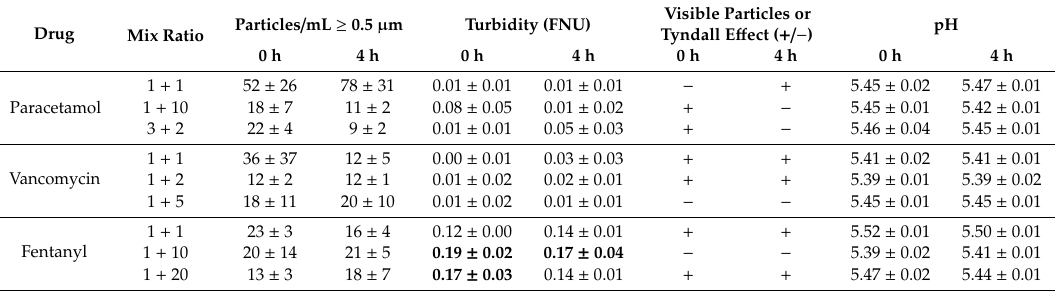
Table 6. Results from precipitation testing after mixing drug and aq Numeta G13E + (bold font indicate values outside the acceptance criteria) (average ± SD; n =